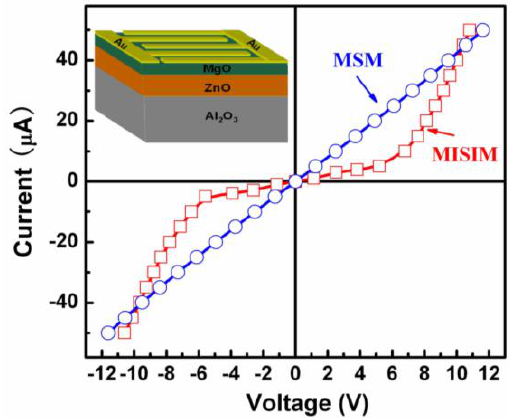
Figure 2. Current-voltage characteristics of the ZnO based MISIM and MSM photodetectors under dark condition. The inset shows a schematic diagram of the ZnO MISIM-structured photodetector.